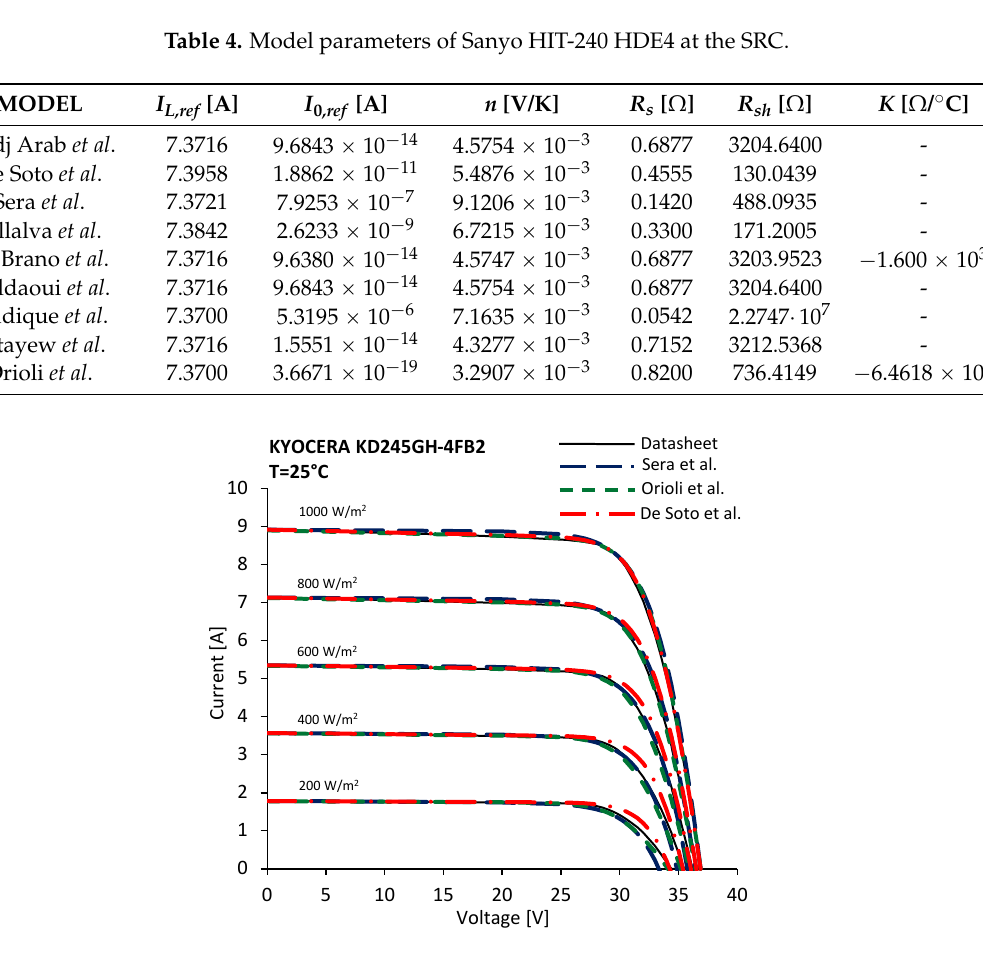
Table 4. Model parameters of Sanyo HIT-240 HDE4 at the SRC.